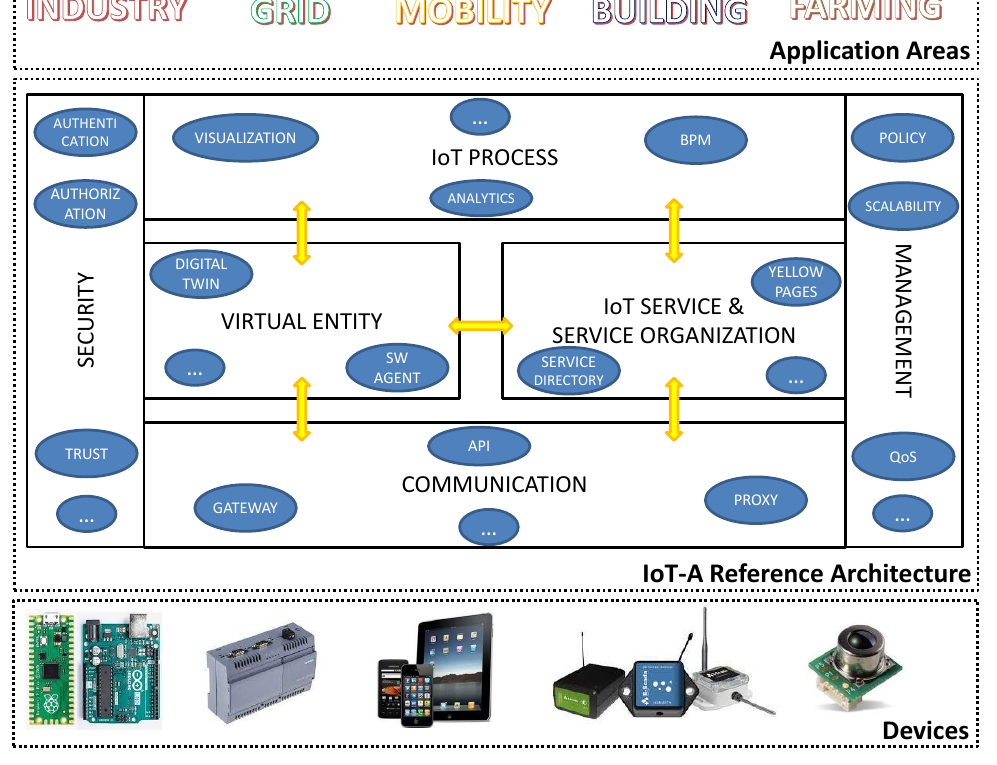
Figure 1. IoT-A reference architecture: architectural layers and main